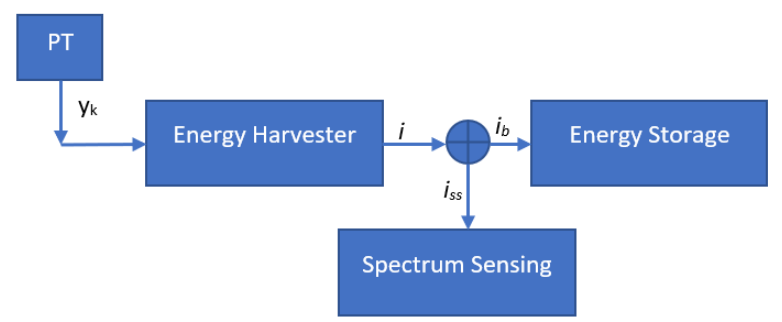
Figure 1. Combined spectrum sensing and energy harvesting by the ST.